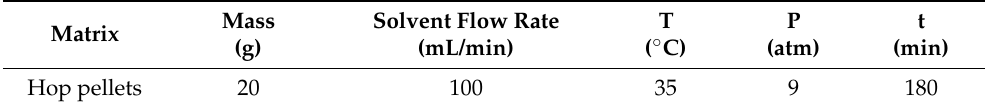
Table 1. Process conditions used during the extraction tests performed by HFC system on hop pellets (T, extraction temperature; P, extraction pressure; t, extraction time). Mass Solvent Flow Rate T P t Matrix (g) (mL/min) ( ◦ C) (atm) (min) Hop pellets 20 100 35 9